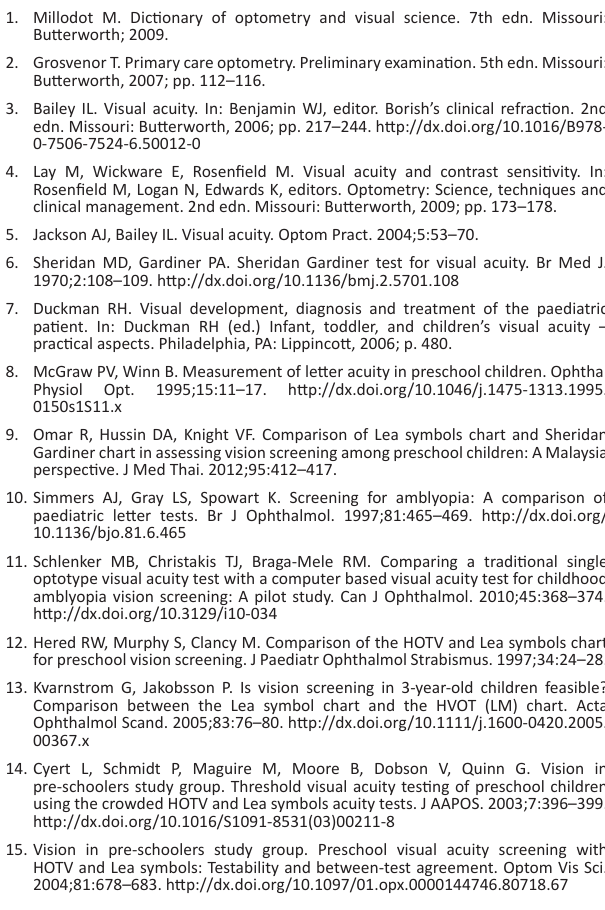
VA, Visual acuity; OD, right eye; OS, left eye; OU, both eyes. Note: Units are